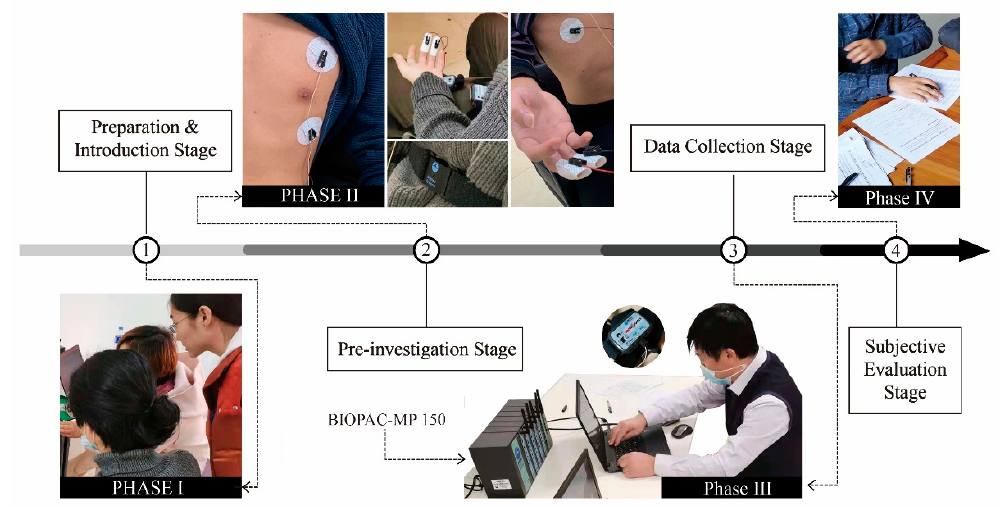
Figure 3. A schematic diagram of the experiment flow.